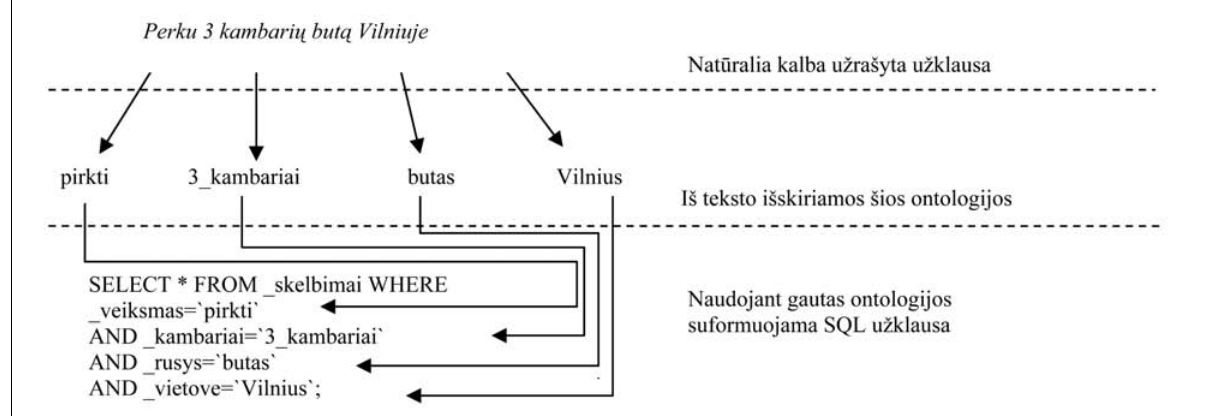
Fig 5. Request transformation in SQL request